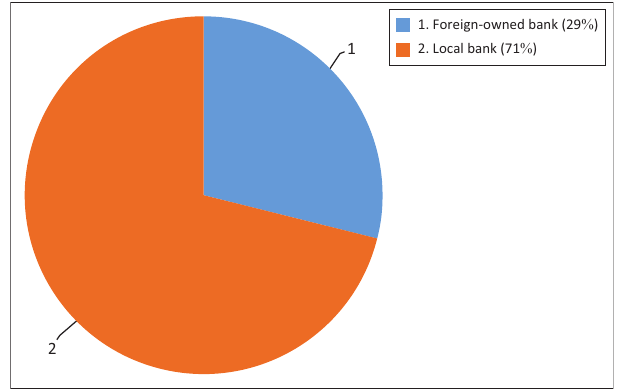
FIG URE 1: Foreign-owned and locally owned banks.